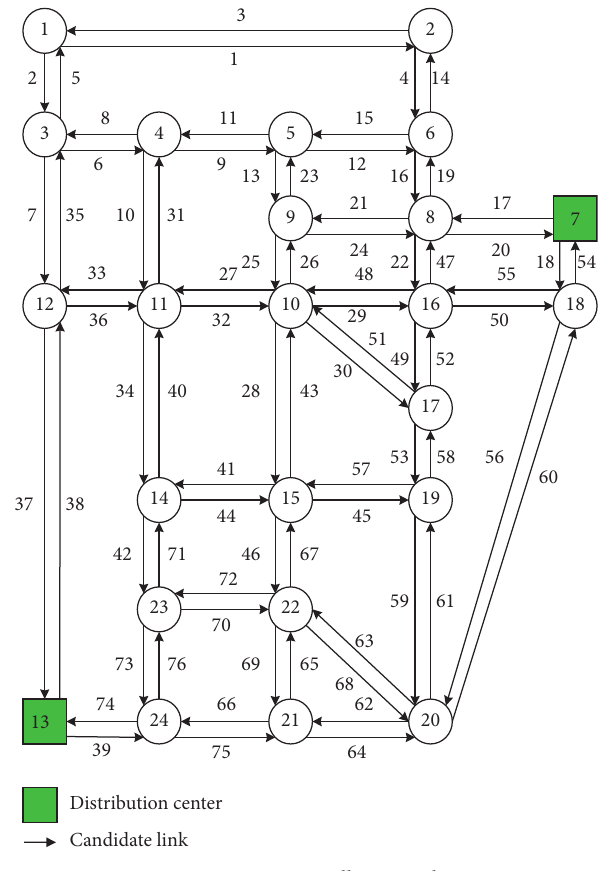
Figure 3: Sioux Falls network. Table 2: Network